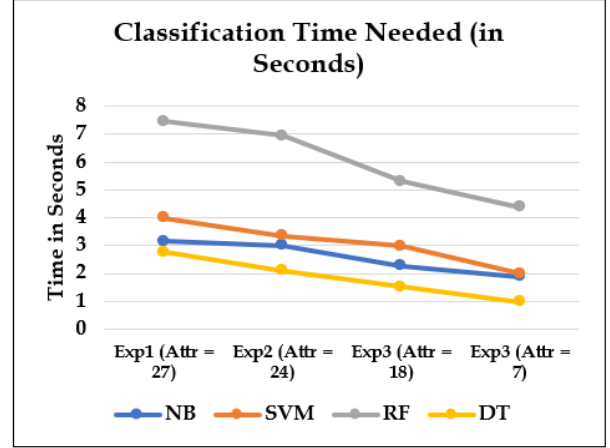
Figure 4. Time Required for Classification in Testing Phase by all Four Models.